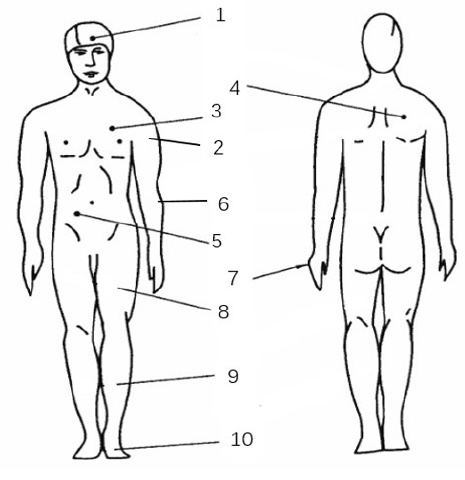
Figure 2. Measuring points of human skin temperature.